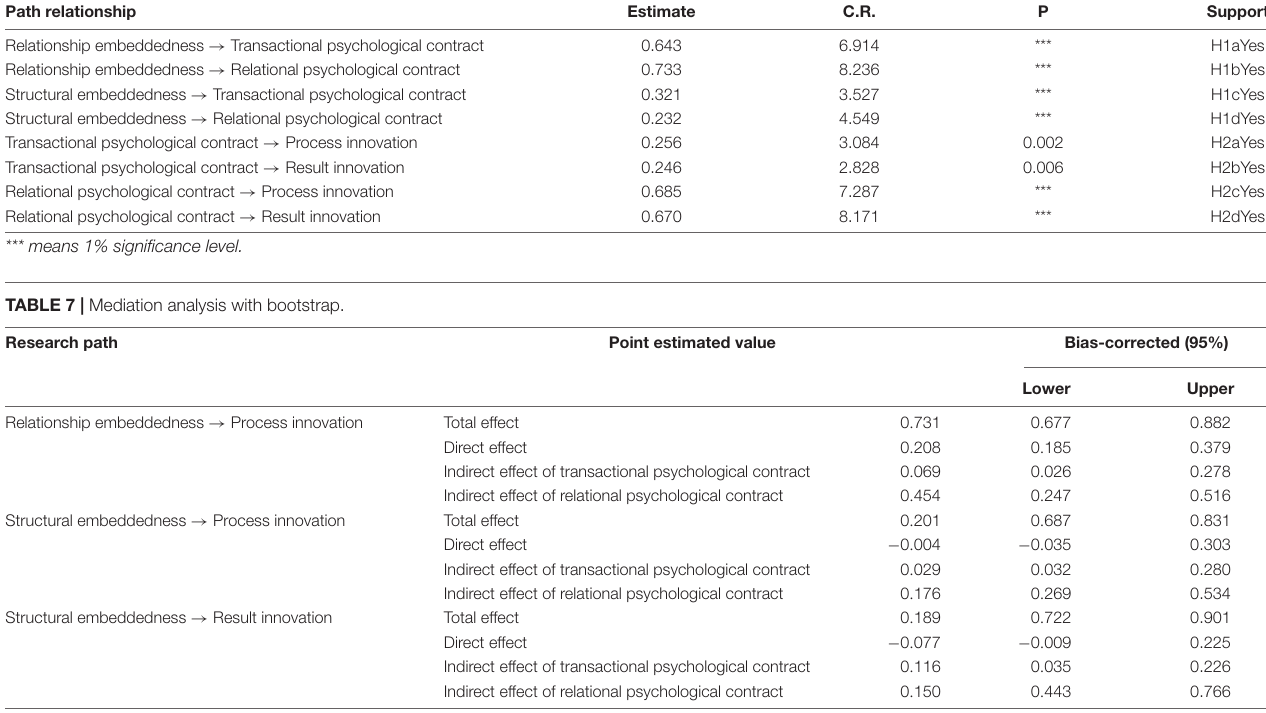
TABLE 6 | Results of path analysis. Path relationship